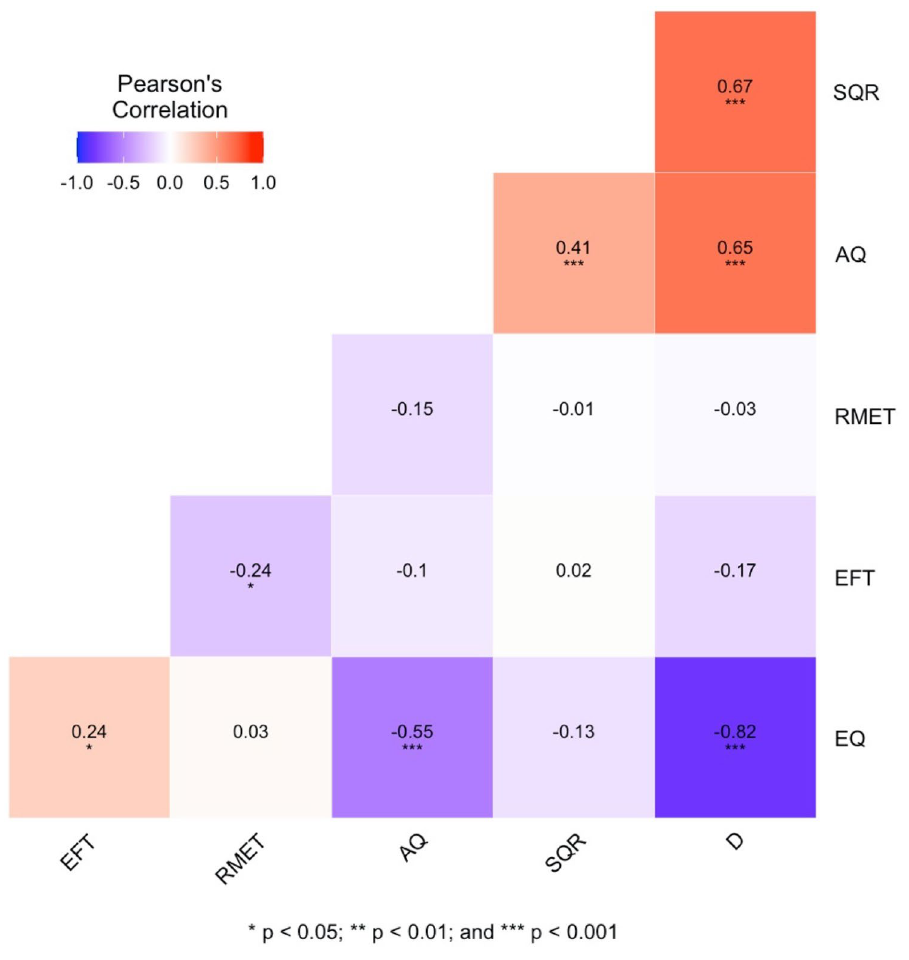
Figure 1. Correlation heatmap for autism-related variables.